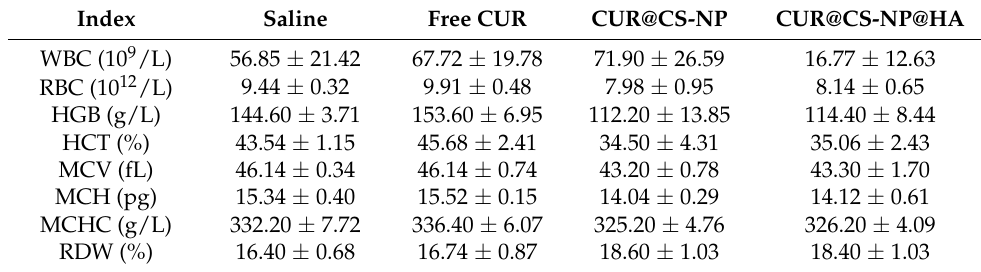
Figure 7. In vivo antitumor potency study. ( A ) Tumor volume growth curve during treatment. ( B ) Representative tumor photos from the different treatment groups. ( C ) Final tumor weights after 10 days of treatment. ( D ) Expression of stemness indicators in 4T1 primary tumors (* p < 0.05; ** p < 0.01). ( E ) Representative HE examinations of tumor tissues (scale bar = 51 µ m). Table 6. After treatment, routine blood analysis of mice in each